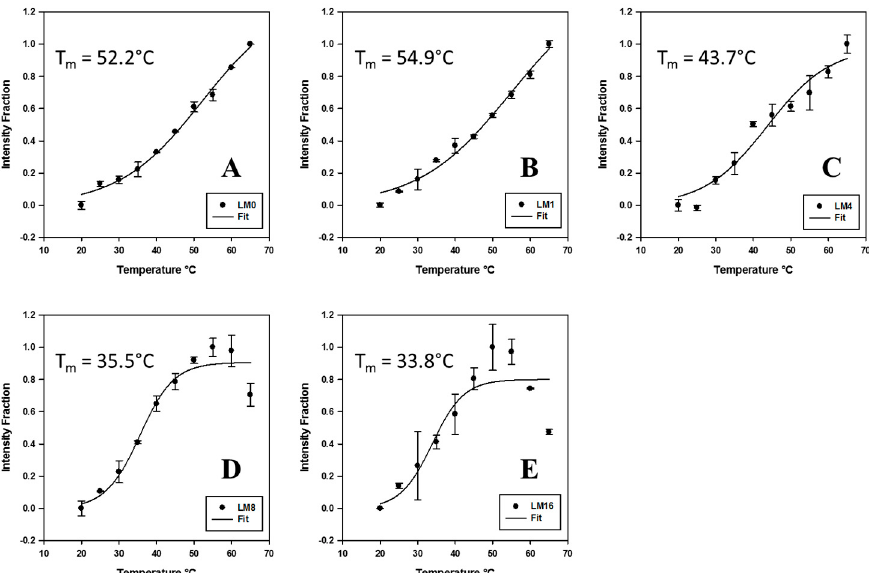
Figure 4. Sigmoidal fittings of T m curves for titrating sisomicin against annealed FM1 r(CUG) 10 : ( A – E ) T m at ligand to RNA molar ratios of 0, 1, 4, 8, and 16. Annealed FM1 r(CUG) 10 RNA sample concentration 200 nM and volume size 150 µL; ligand addition volume size 1.5 µL; fluorescence setting: excitation at 485 nm, emission at 500–600 nm, and slit width of 3 nm in a range of 20–65 °C.